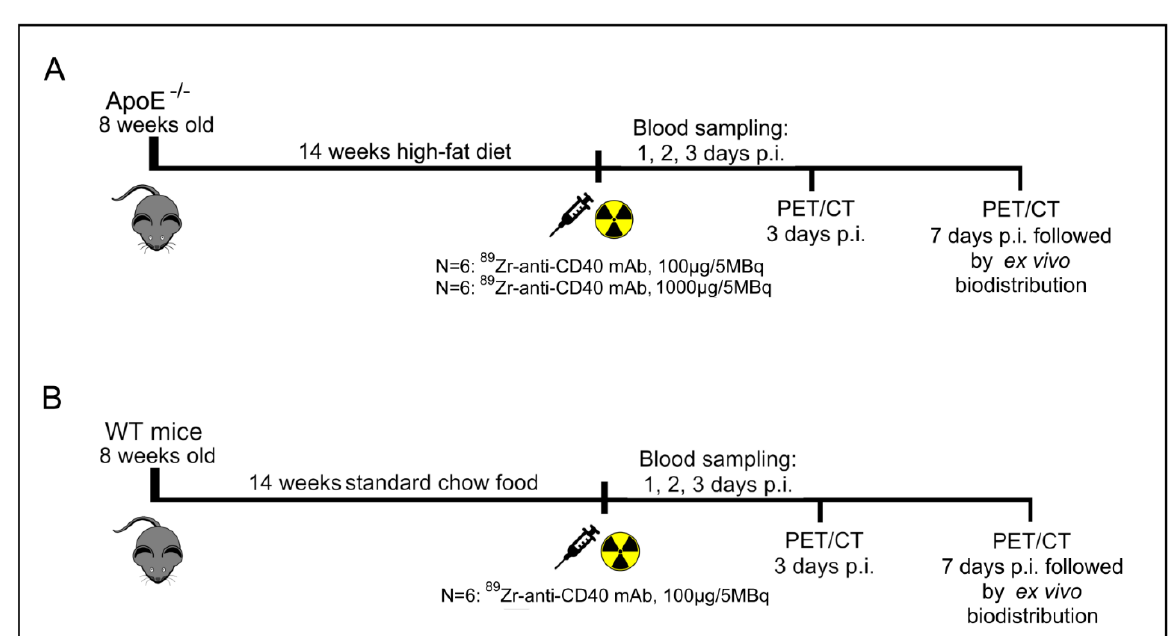
Figure 1. Schematic overview of the experimental design of PET and ex vivo biodistribution studies with [ 89 Zr]Zr-anti-CD40 mAb. ( A ) Timeline for the ApoE − / − mice injected with either a “low dose” of 100 µg-5 MBq (N = 6 ) or “high dose” of 1000 μg -5 MBq [ 89 Zr]Zr-anti-CD40 mAb (N = 6). ( B ) The timeline for the WT mice injected with 100 µg-5 MBq [ 89 Zr]Zr-anti-CD40 mAb (N = 6).